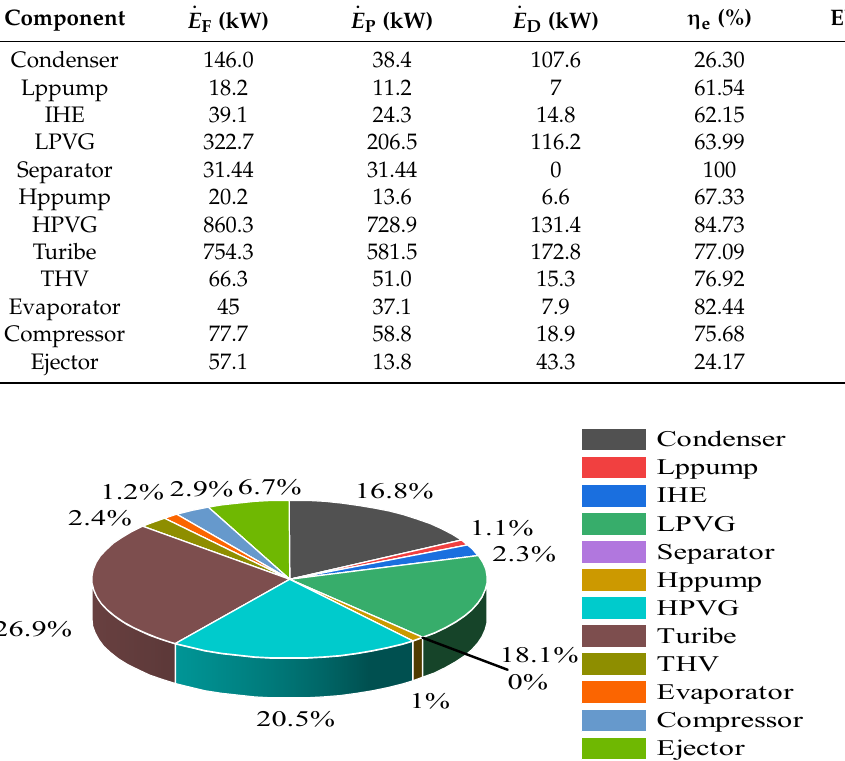
Table 11. Exergy analysis results of the system.